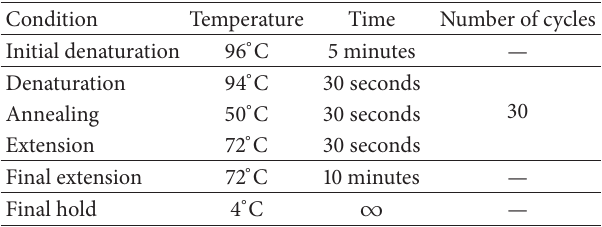
Table 4: Cycling conditions for